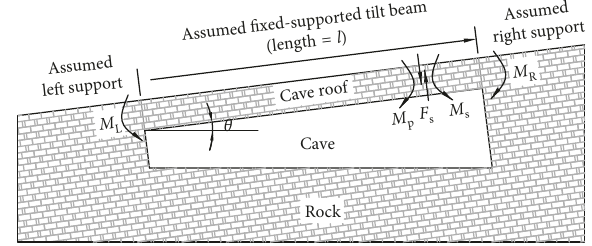
Figure 10: Assumption of the modified